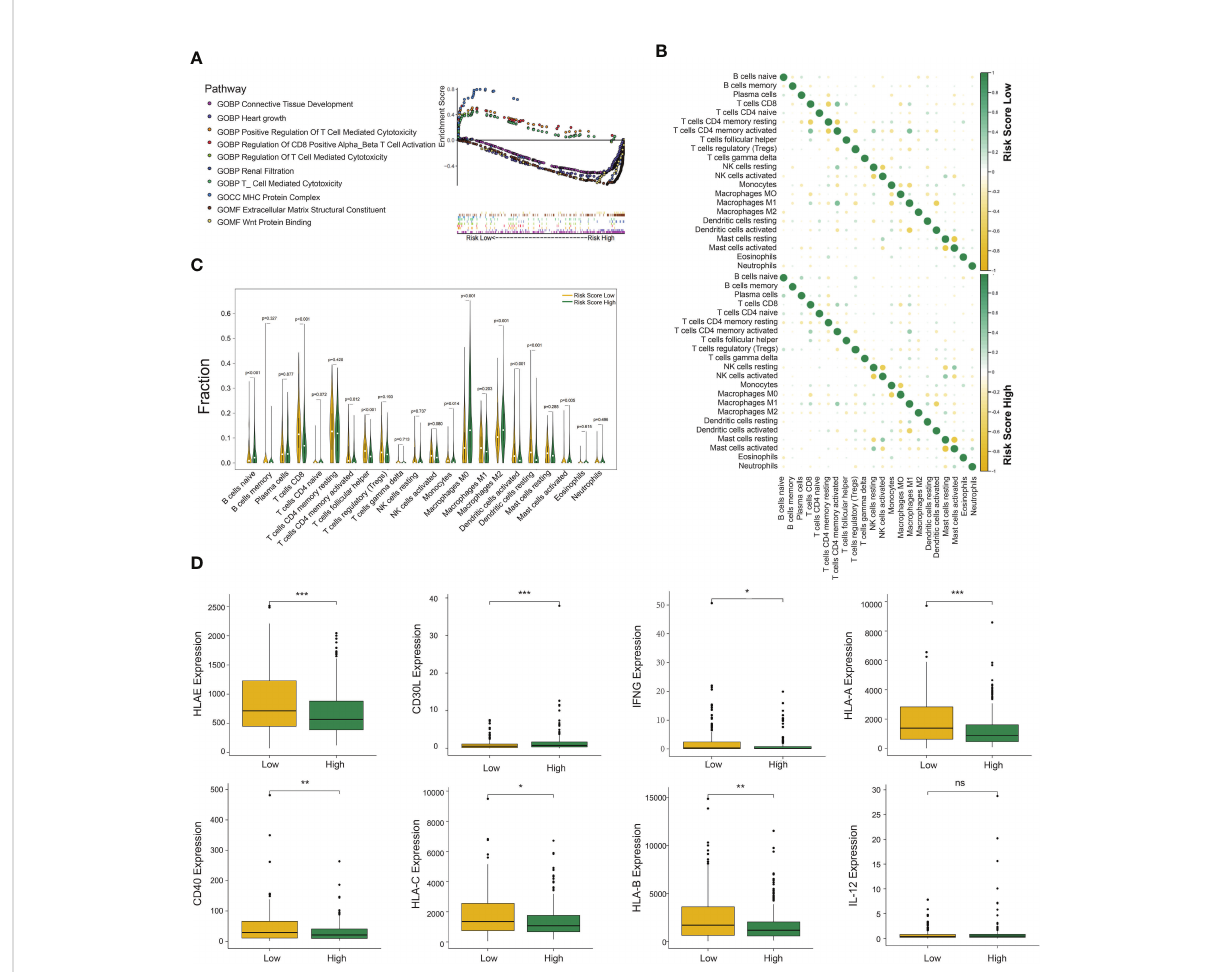
FIGURE 4 Gene set enrichment analysis (GSEA), immune cell in fi ltration, and cytokine expression in the DCRSL and DCRSH groups. (A) Gene ontology (GO) enrichment analysis of the activation states of immune-related pathways in distinct DC-related risk score groups. (B) The relationship between the abundance ratios of different tumor immune-in fi ltrating cells. (C) The horizontal axis and vertical axis represent tumor-in fi ltrating immune cells and relative percentages, respectively. Yellow and green represent the DCRSL group and the DCRSH group. (D) The expression of cytokines associated with DC between the DCRSL group and the DCRSH group. The upper and lower ends of the box indicate the interquartile range of values. The line in the box indicates the median value, and the black dot indicates the outlier. The asterisks indicate statistical p-values (*<0.05, **<0.01,